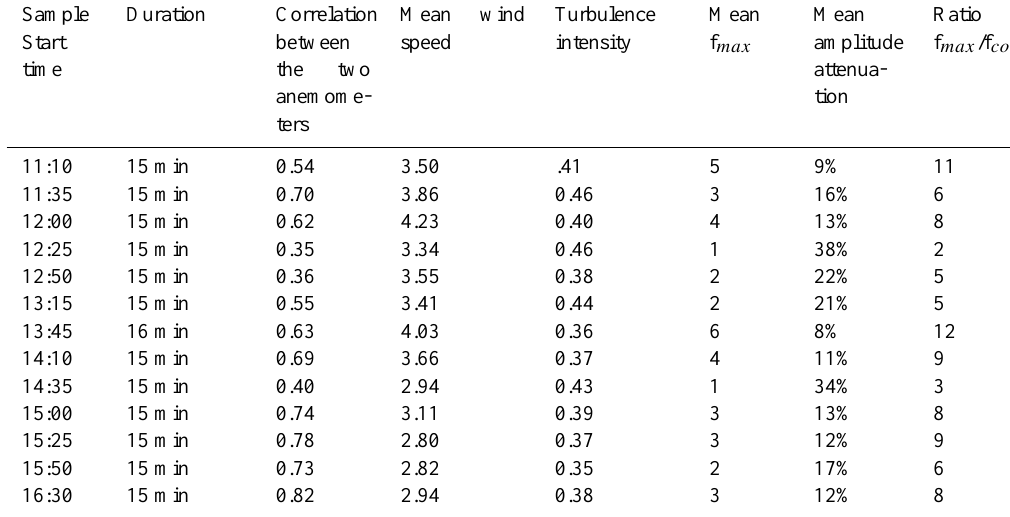
Table 2: Data pertaining to the upper frequency limit, f max , the relating amplitude attenuation and the ratio between the previous frequency and the cup anemometer cut-off frequency, f max /f co . Cup anemometer 25-2, date of 30 December 2002.